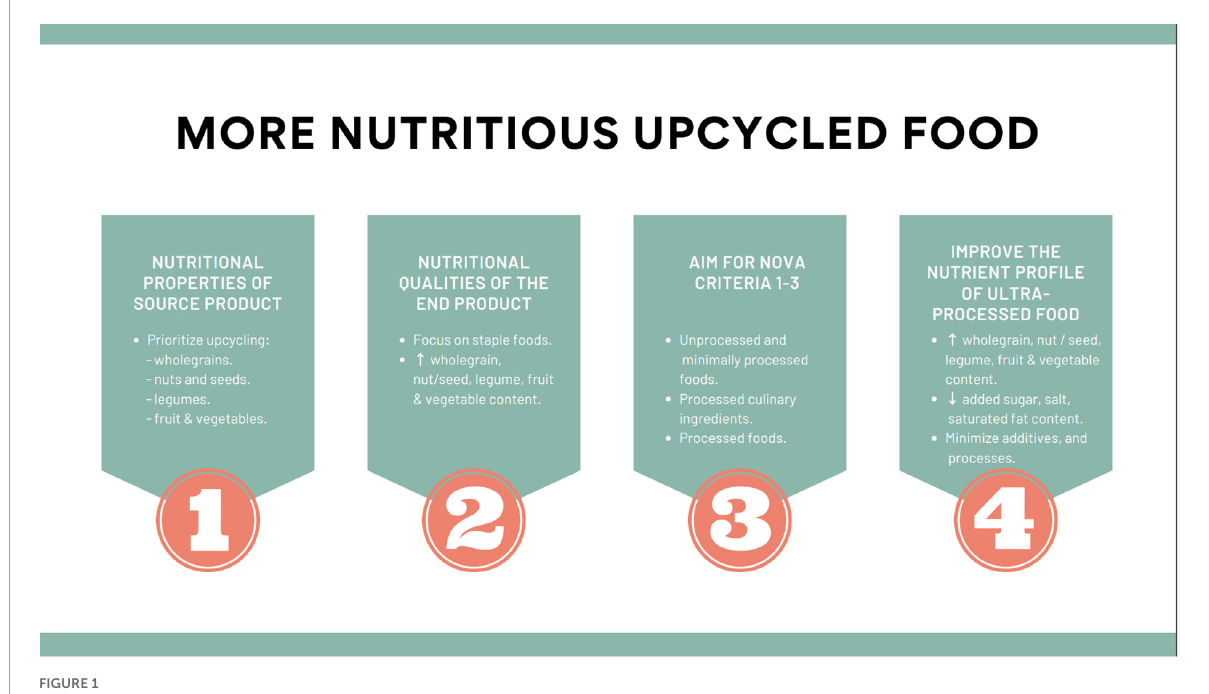
FIGURE1 A summary of key factors to creating more nutritious upcycled